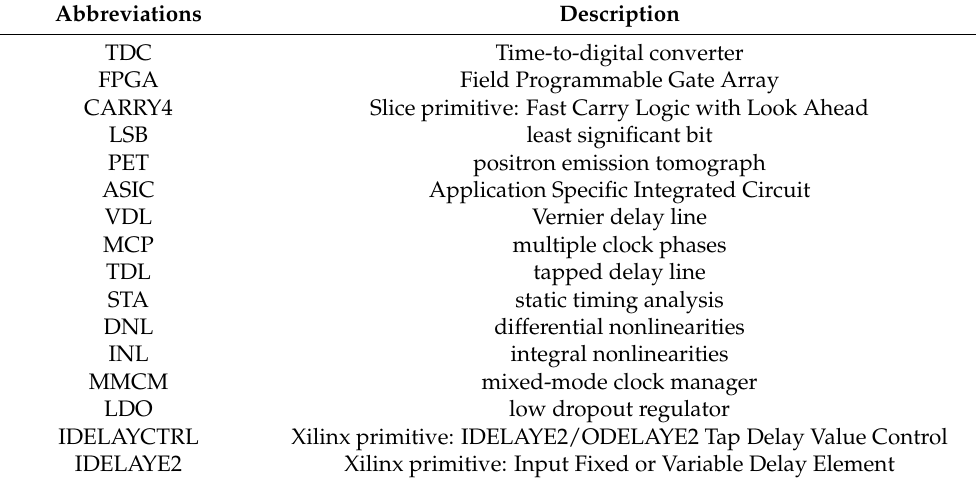
Figure 1. Block diagram of the proposed TDC. The programmable logic (in orange) and processing system (in purple). Table 1. Description of